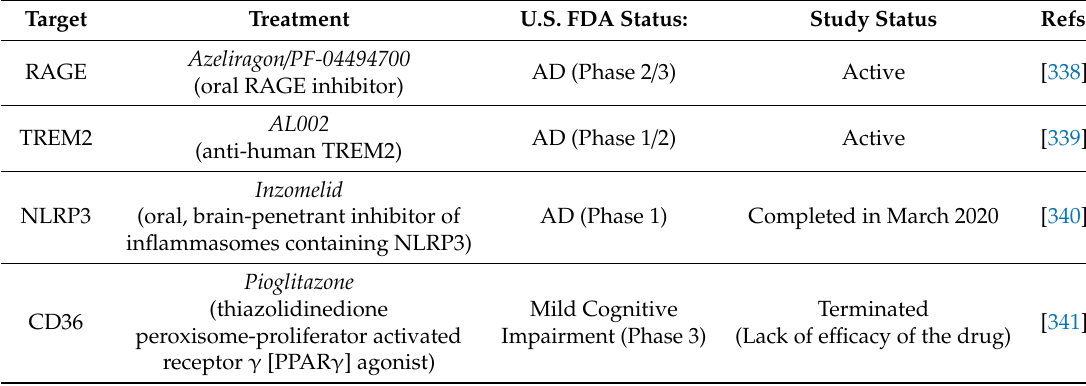
Table 4. Clinical trials targeting PPRs in the treatment of